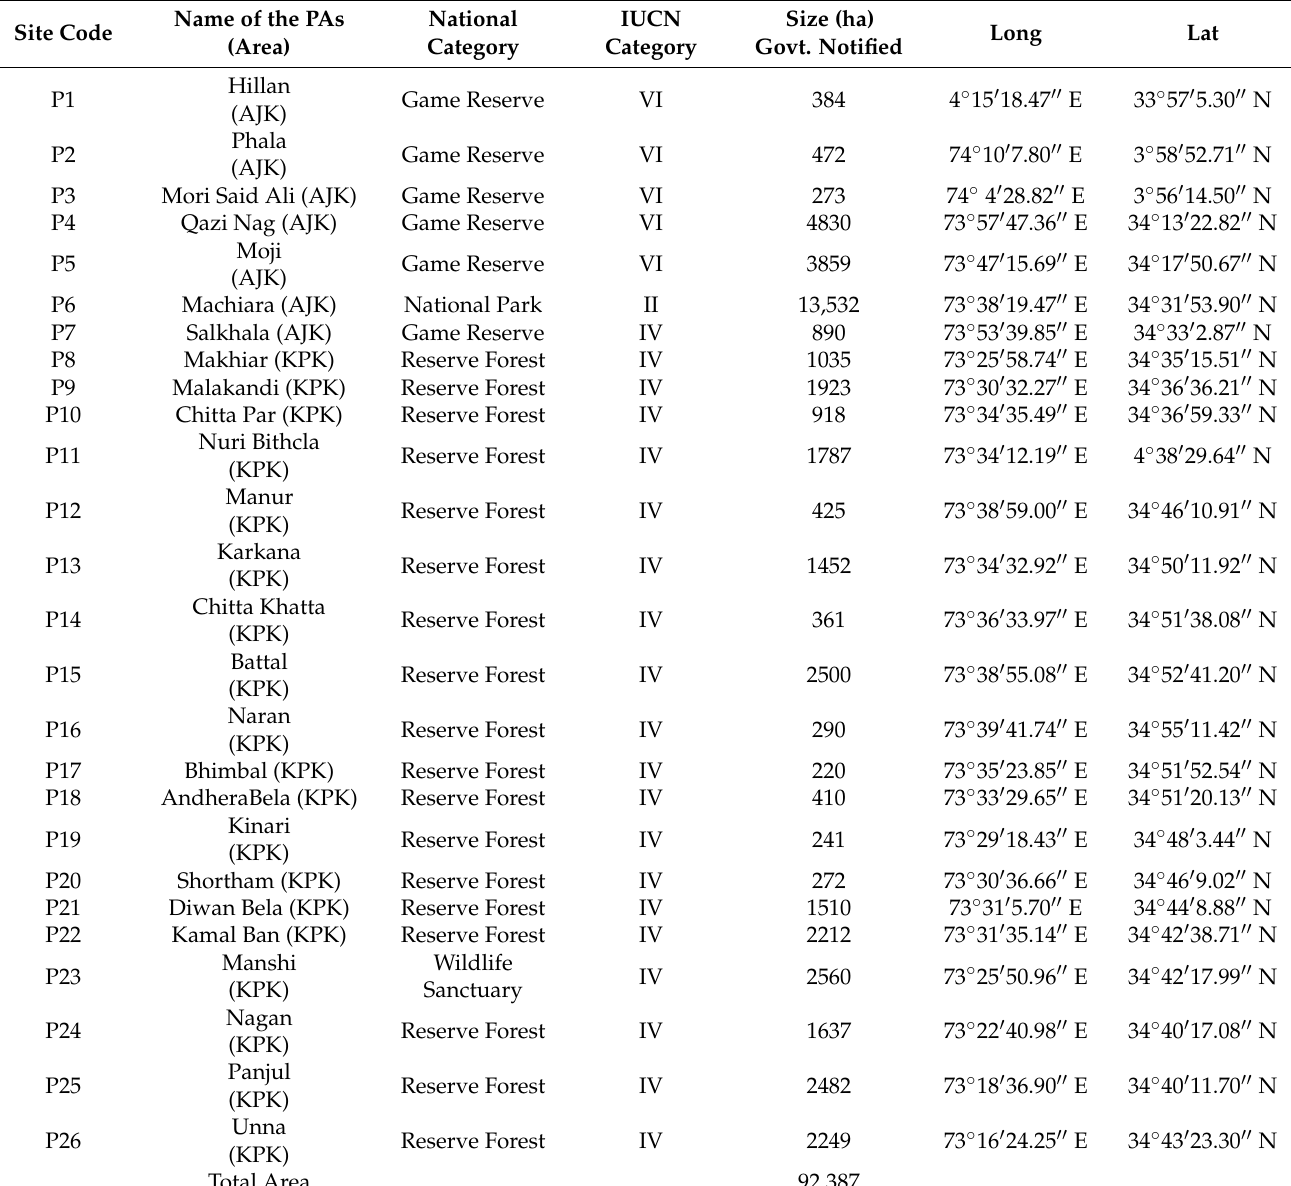
Table 1. Protected areas falling within the potential habitat of the species in